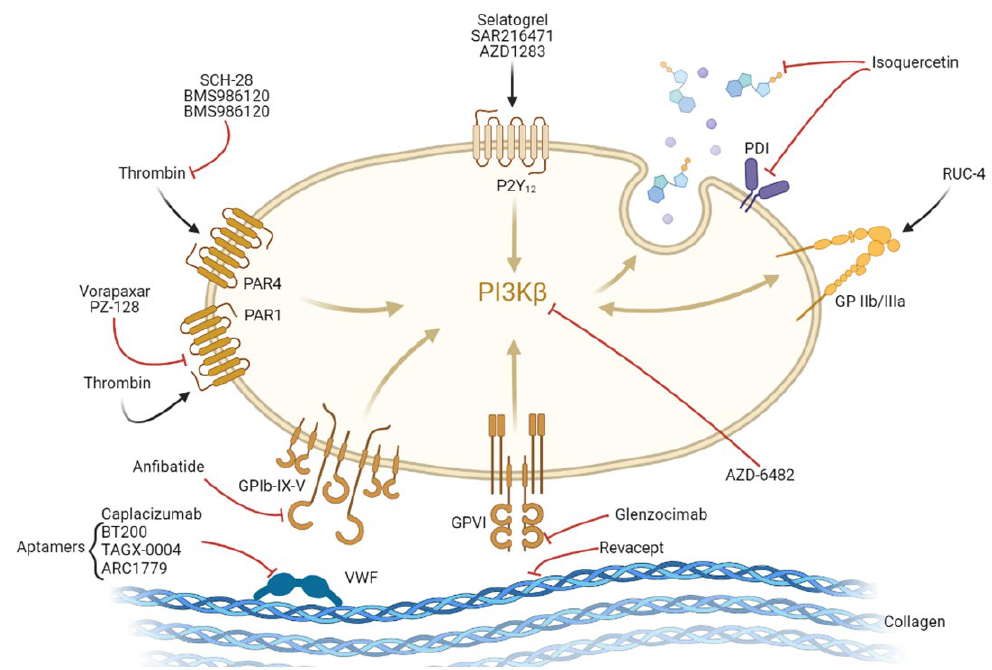
Figure 3. Emerging antiplatelet targets and drugs. PDI: phosphodiesterase; VWF: Von Willebrand factor; GP: glycoprotein; PAR: protease activator receptor.